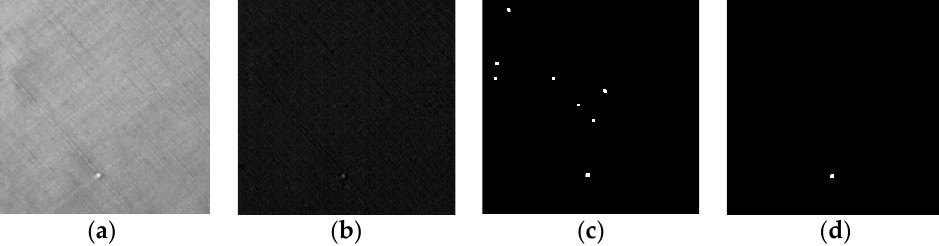
Figure 6. The influence of the local difference analysis module. ( a ) Original image; ( b ) Residual image; ( c ) Segmentation result only with morphological operation; ( d ) Segmentation with LDA. Table 3. Results of different detection methods. Recall Precision F1-Measure Recon + Morph 0.9423